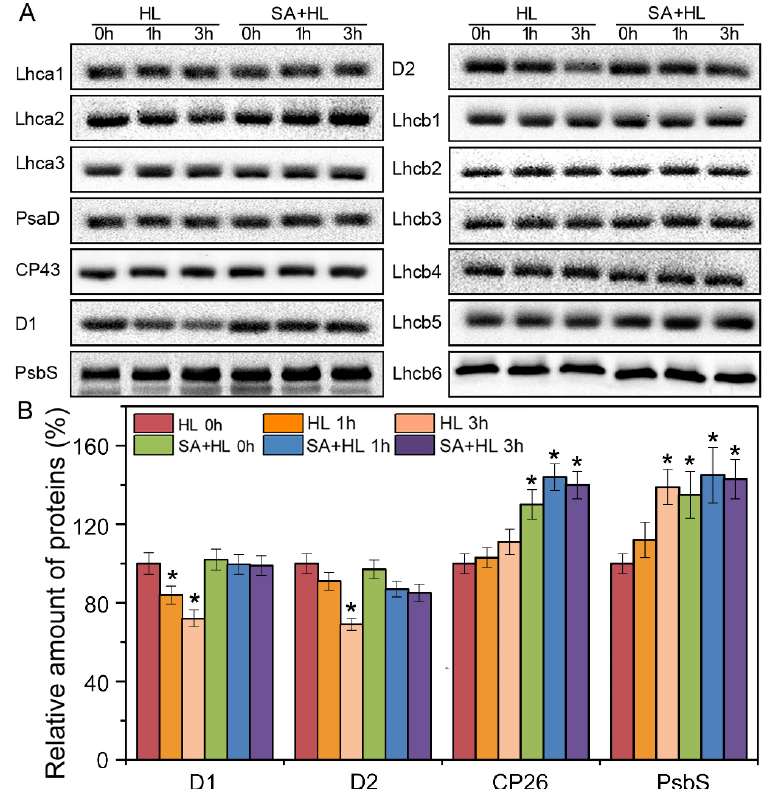
Figure 5. Immunoblot analyses of thylakoid proteins obtained from Arabidopsis thaliana under high light in the presence or absence of SA pretreatment. ( A ) Immunoblotting were done using specific antibodies against representative PSI and PSII proteins. ( B ) Quantitative data for D1, D2, Lhcb5, and PsbS proteins in Arabidopsis thaliana under high light with or without SA pretreatment. Results are presented relative to the amount of the respective control (HL 0h, 100%). Significantly different values are marked with an asterisk ( * ) at p < 0.05 level ( n = 4). HL, high light. SA + HL, high light after SA pretreatment for 3